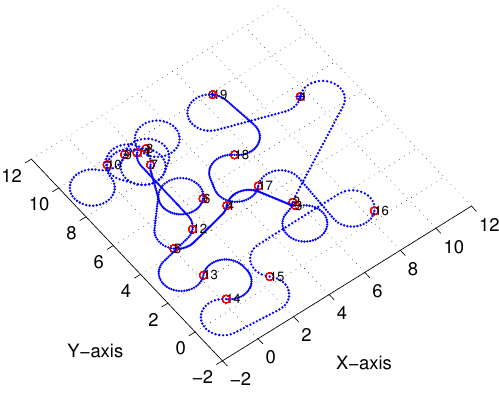
Figure 15. X – Y projection of Bezier interpolation three-dimensional (3D) Dubins curves (case 1).